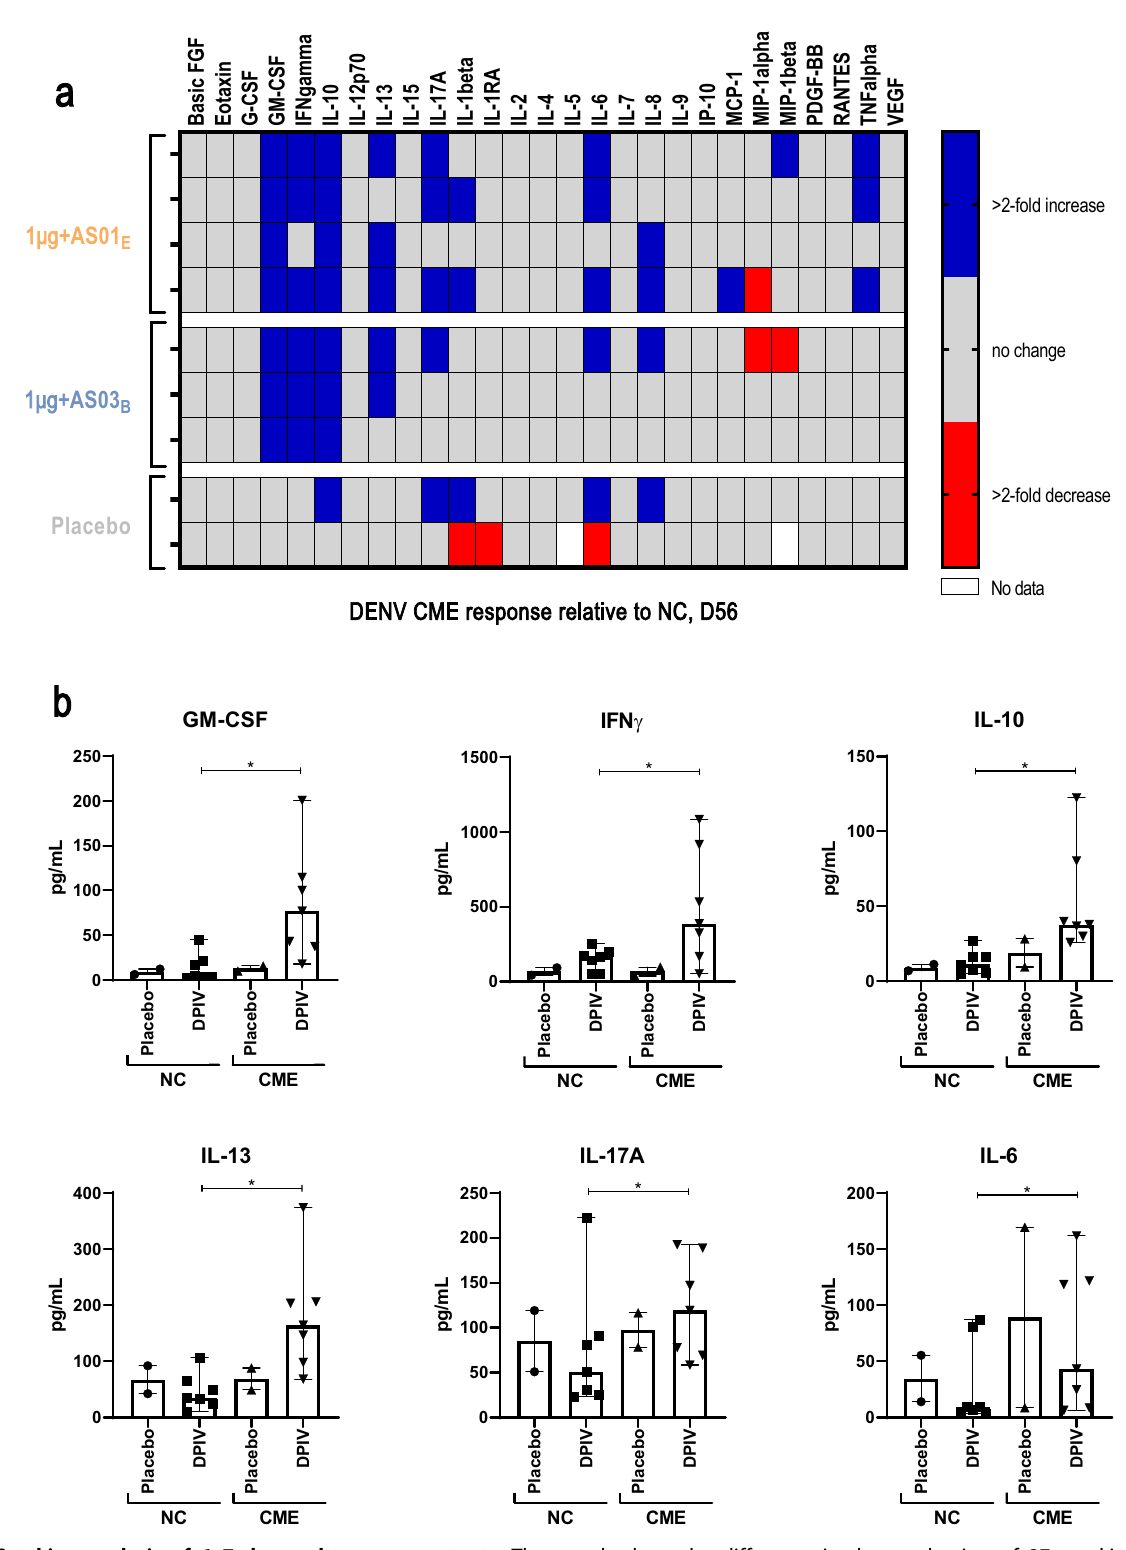
Fig. 5 Cytokine analysis of 6 – 7 days culture supernatants. The panels show the difference in the production of 27 cytokines (using combined DENV capsid/pre-membrane and envelope region peptide pools) at day 56 ( a ) and the concentrations of cytokines showing a greater than two-fold change in at least four vaccinated individuals ( b ) (adapted according-to-protocol cohort for immunogenicity subset). Error bars represent the Min and Max values in each group. CME, combined capsid/pre-membrane and envelope; D, day; D56, 28 days post- dose 2; DENV, dengue virus; FGF, fi broblast growth factor; G-CSF, granulocyte colony-stimulating factor; GM-CSF, granulocyte-macrophage colony-stimulating factor; IFN, interferon; IL, interleukin; IP-10, interferon-inducible protein 10; MCP-1, monocyte chemoattractant protein-1; MIP, macrophage in fl ammatory protein; NC, negative control; PDGF, platelet-derived growth factor; TNF, tumor necrosis factor; VEGF, vascular endothelial growth factor. *Signi fi cant difference in the DPIV groups comparing NC vs CME stimulation as assessed by Holm-Sidak using α = 0.05; computations assumed that all time points were sampled from populations with the same